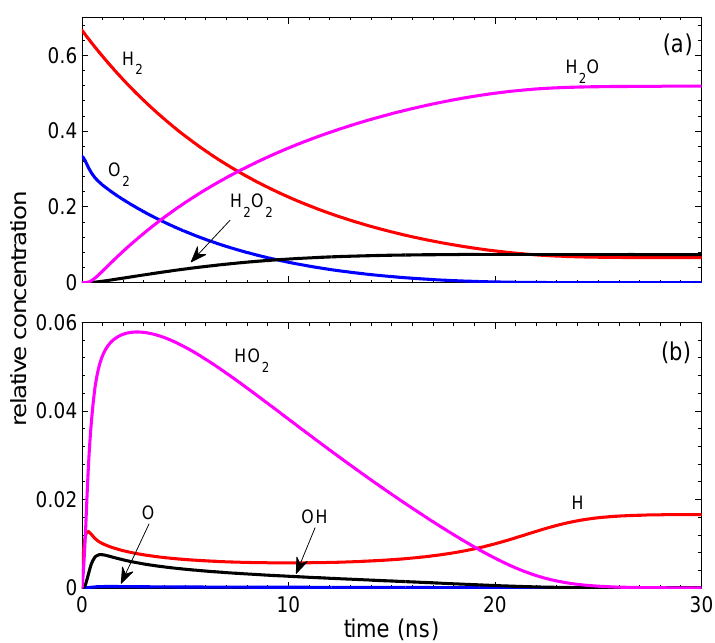
Figure 1. ( a ) Relative concentration of stable molecules as functions of time; ( b ) Concentration of radicals at different moments of time. The solution is presented for ε + ( i = 1,2,3,4).